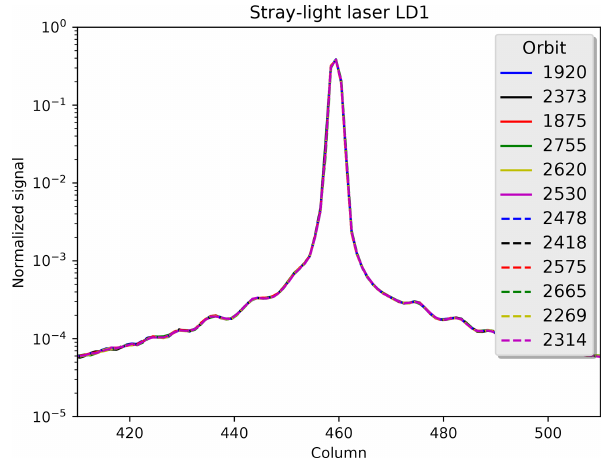
Figure 15. Results of all stray-light measurements with SLS-1 dur- ing the E1 phase.